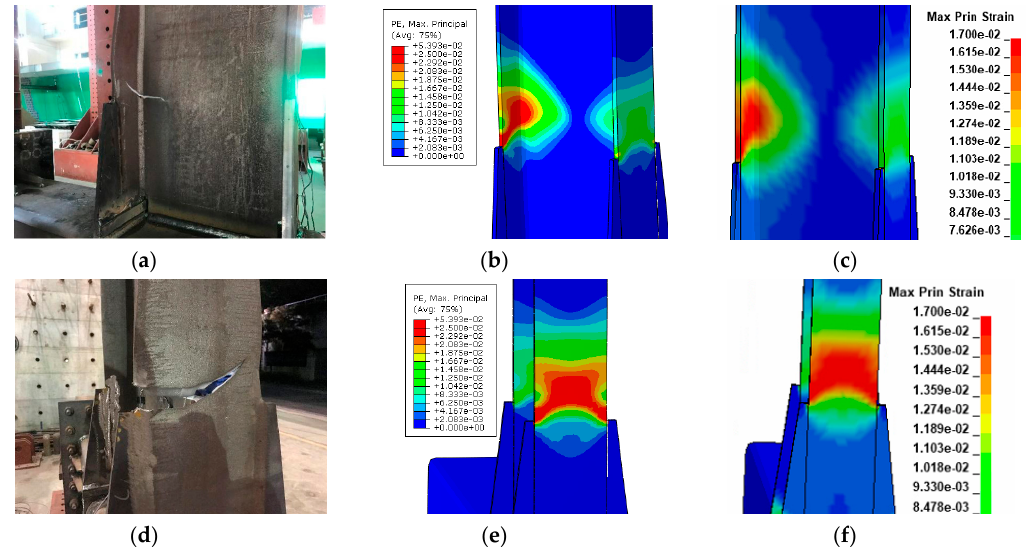
Figure 9. Comparison between failure modes of test specimen [16], with permission, and maximum principal strain distributions of numerical models at the drift angle of 5.0%. ( a ) Failure of beam web for test specimen; ( b ) maximum principal strain distribution on beam web for LS-DYNA model; ( c ) maximum principal strain distribution on beam web for ABAQUS model; ( d ) failure of beam flange for test specimen; ( e ) maximum principal strain distribution on beam flange for LS-DYNA model; ( f ) maximum principal strain distribution on beam flange for ABAQUS model.